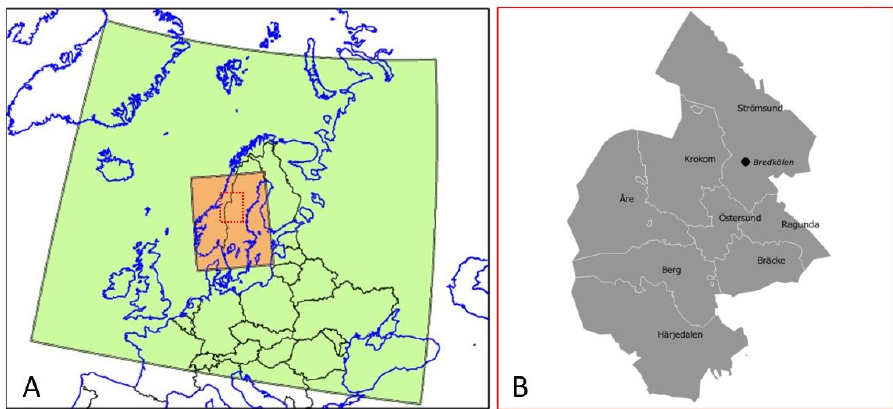
Figure 1. MATCH domains covering northern Europe (panel A , green), at a 0.1° × 0.1° resolution, and the inner domain covering Jämtland Härjedalen and surrounding areas (panel A , orange), at 4 km × 4 km resolution. In panel ( B ) the Jämtland Härjedalen region municipalities are illustrated together with an approximate location of the EMEP station Bredkälen.